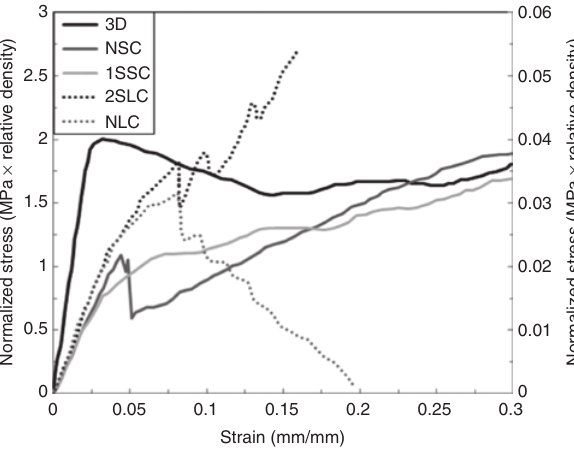
Figure 9 High strain rate (1000 s -1 ) compressive stress-strain response with compressive stress multiplied by relative density (MPa × ρ / ρ ) plotted against strain. Note that the large-cell foams 0 (i.e., 2SLC and NLC) are plotted against the secondary axis on the right side of the plot.